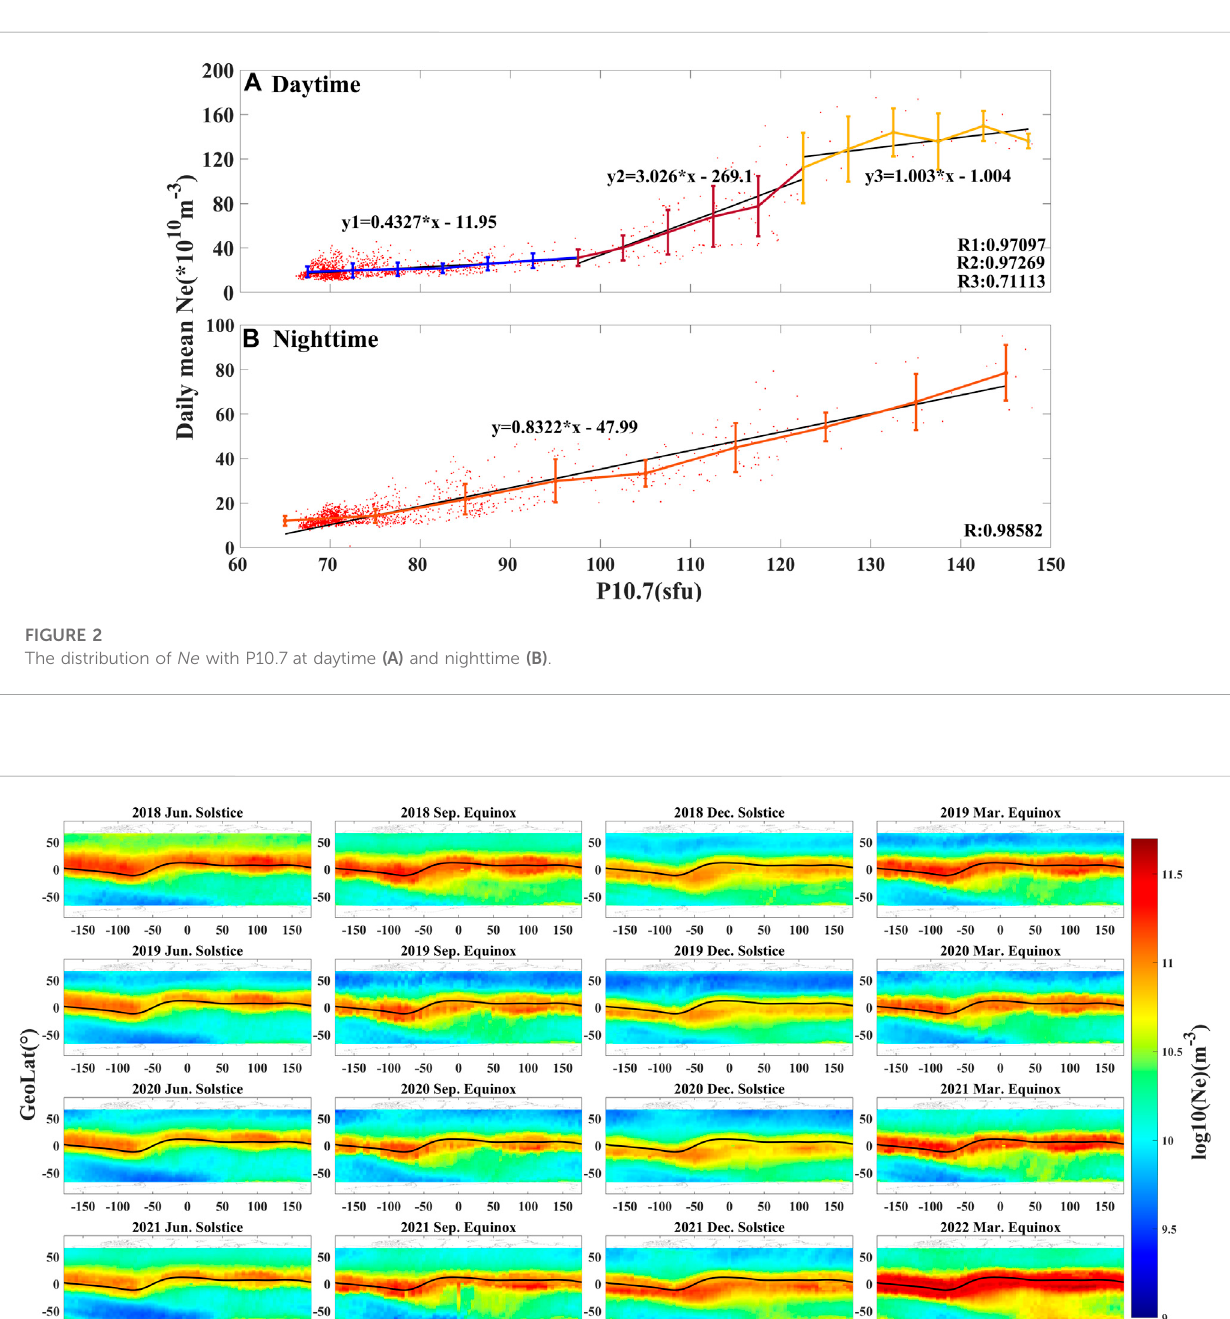
the Ne measured by CSES, and a, b are the slope and intercept of the y1 fi t ( a = 0.4327, b = − 11.95), respectively. The R marked in the bottom right corner stands for ’ root mean square error ’ . For the nighttime, Ne was normalized to the y fi t by the same method, among which P = 100, a = 0.8322, b = − 47.99 (Figure 2B).